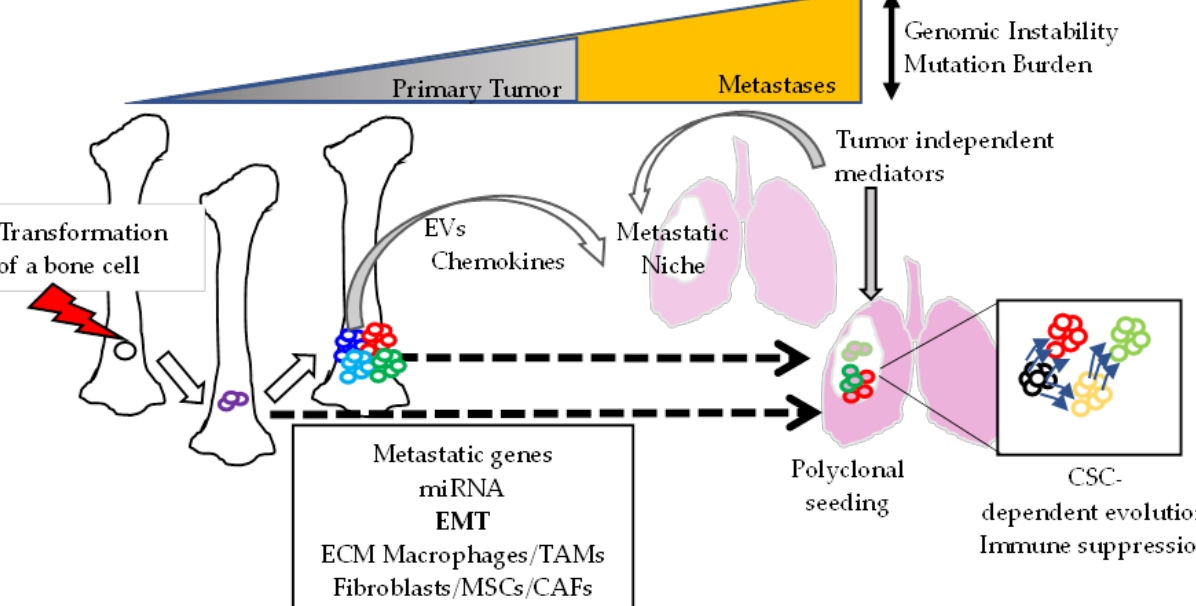
Figure 3. Schematic view of the formation of osteosarcoma-derived lung metastases accompanied by increased genomic alterations. The metastatic capacity of bone tumor cells depends on gene alterations (metastatic genes) and epigenetic regulation by microRNA (miRNA). Both can contribute to the epithelial – mesenchymal transition (EMT). The extracellular matrix (ECM) and tumor-associated fibroblasts (CAFs) and macrophages (TAMs) are responsible for microenvironment-mediated promotion of tumor progression. Cells can escape the primary site during early or late stages of tumor development (as indicated by the dotted arrows). The primary tumor produces factors that can travel in extracellular vesicles (EVs) to induce or activate metastatic niches. The metastatic niche could be regulated by tumor-independent factors that induce the host to be highly permissive for metastasis development. Polyclonal seeding can be associated with a hierarchical progression, with cancer stem cells (CSCs) as an initiating population of metastases. MSCs, mesenchymal stem